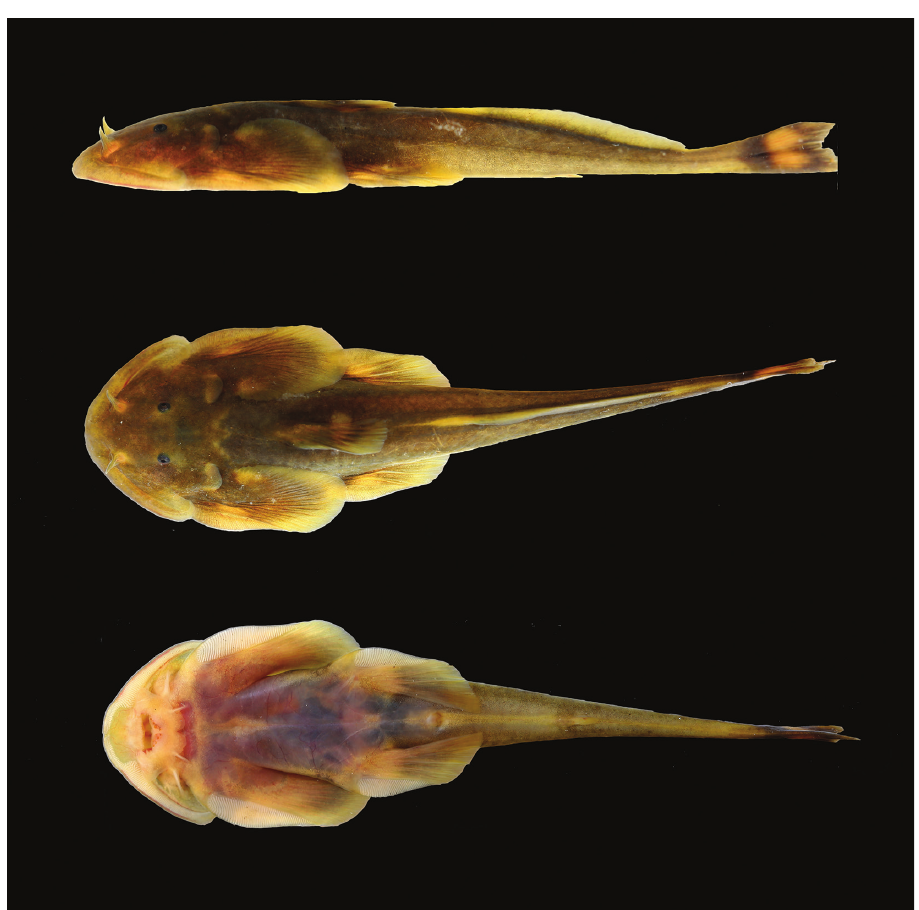
Figure 1. Oreoglanis hponkanensis , SEABRI CXY20150104, paratype, male, 70.6 mm SL. Dorsal fin without spine and with i, 5 (7) rays. Adipose fin with long base. Anal fin with i, 2 (7) rays. Caudal fin emarginate, with 6/6 (7) rays. Pelvic fin greatly enlarged, with convex distal margin and i, 5 (7) rays; first ray flattened, with numerous plicae on ventral surface; tip of pelvic fin surpassing anus, and anus at midpoint between posterior end of pelvic fin base and tip of pelvic fin. Pectoral fin greatly enlarged, with- out spine and with i, 16 (4) or i, 17 (3) rays; first ray flattened, with numerous plicae on ventral surface. Tip of pectoral fin reaching beyond pelvic fin origin; Vertebrae 25+15=40 (3), or 26+14=40